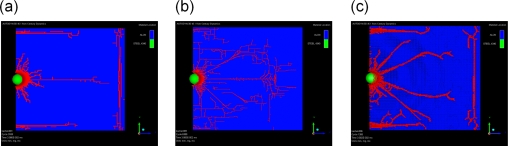
Snapshots of simulations of the edge-on impact system of Figure 22 using a primitive discretization of the geometry of the system in terms of hexahedral elements. (a) FEM with mesh resolution of 0.5mm. (b) FEM with mesh resolution of 1.0mm. (c) SPH with mesh resolution of 0.5mm. All computational results are obtained using a commercial code (Autodyn-3D) and are different in terms of the damage pattern of the cracks propagating through the material 3 μs after impact.